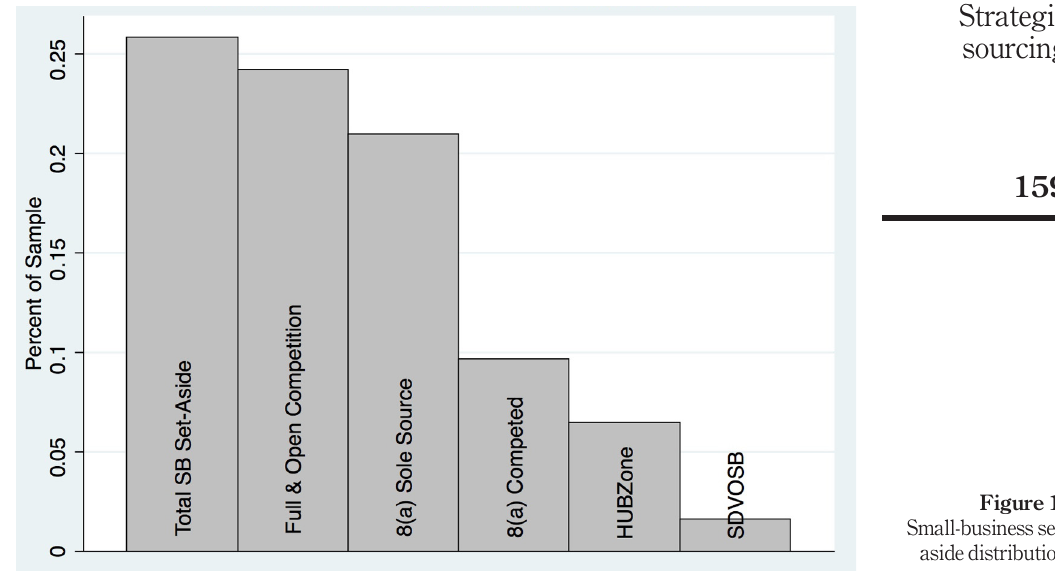
Figure 1. Small-business set- aside